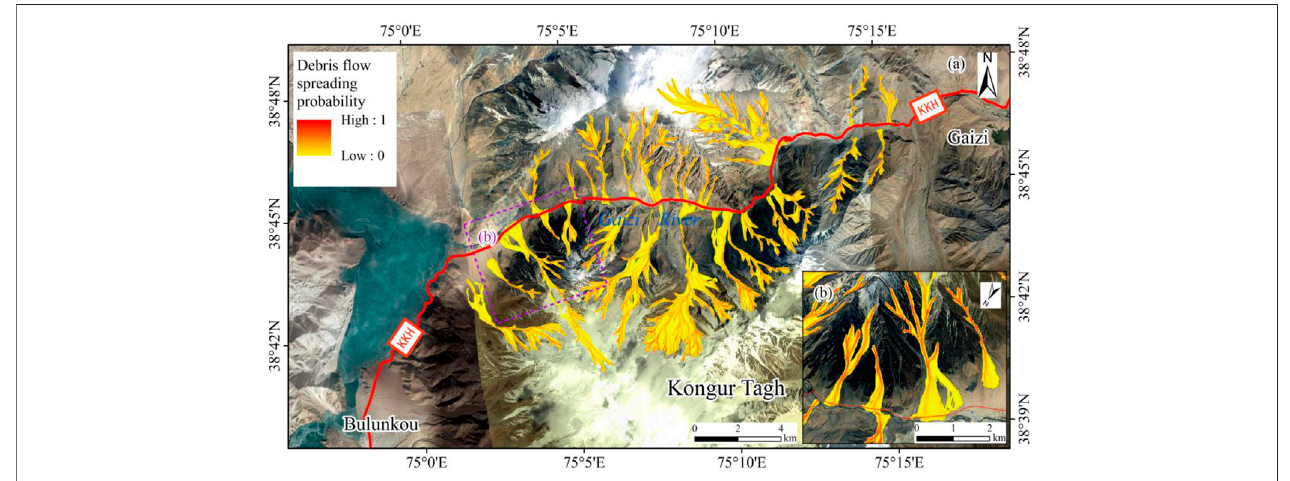
FIGURE 7 | Debris fl ow spreading probability map of the Gaizi-Bulunkou Section of the Karakoram highway. (A) General map; (B) Detailed map.